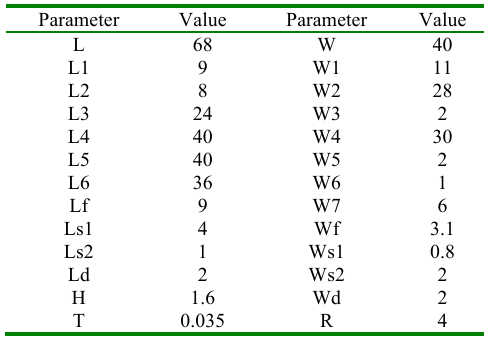
TABLE II. The Optimized Dimensions of the Studied UWB MIMO Antenna in (mm)